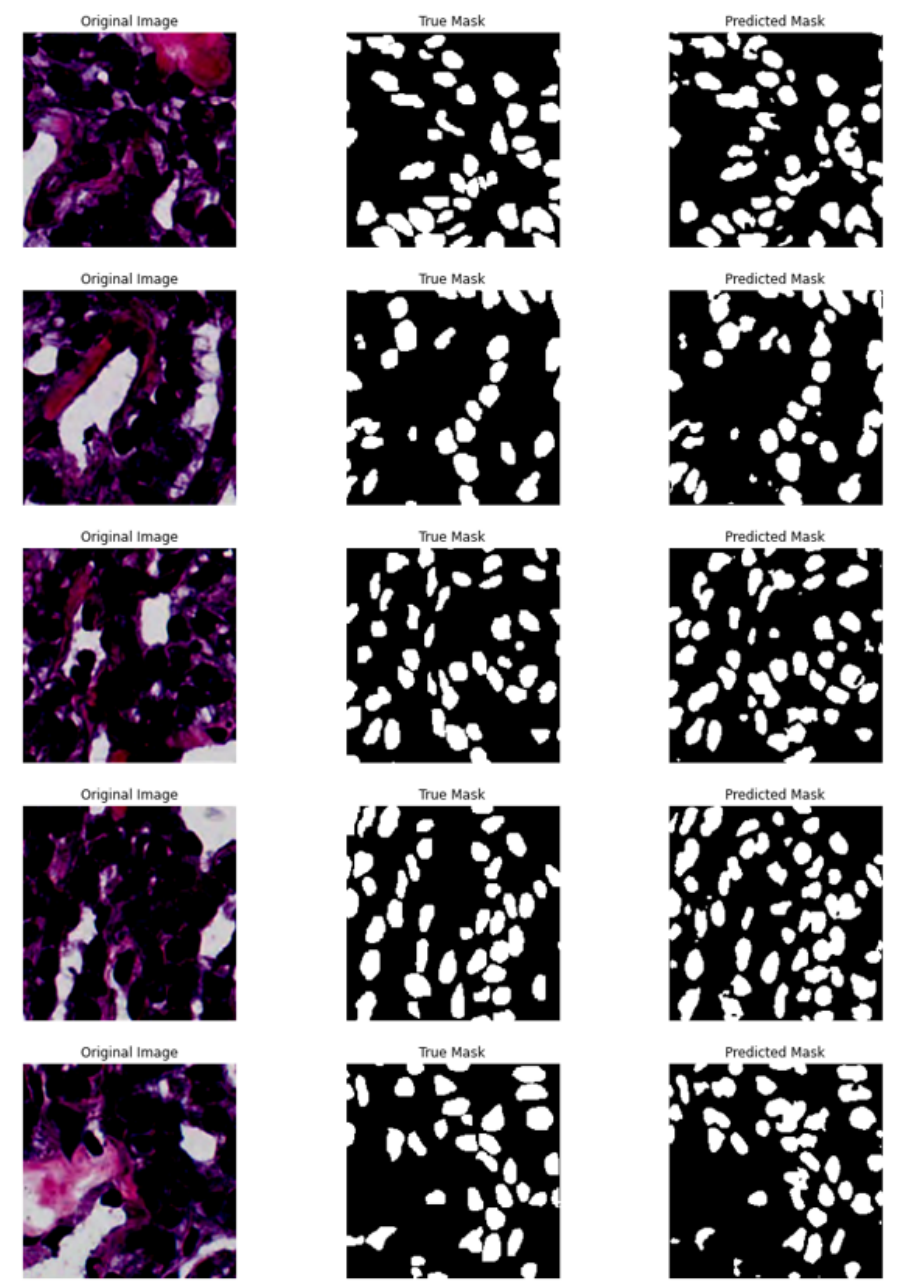
Figure 8. From left to right: the original images, the ground-truth segmentation, the predicted segmentation for the MoNuSeg